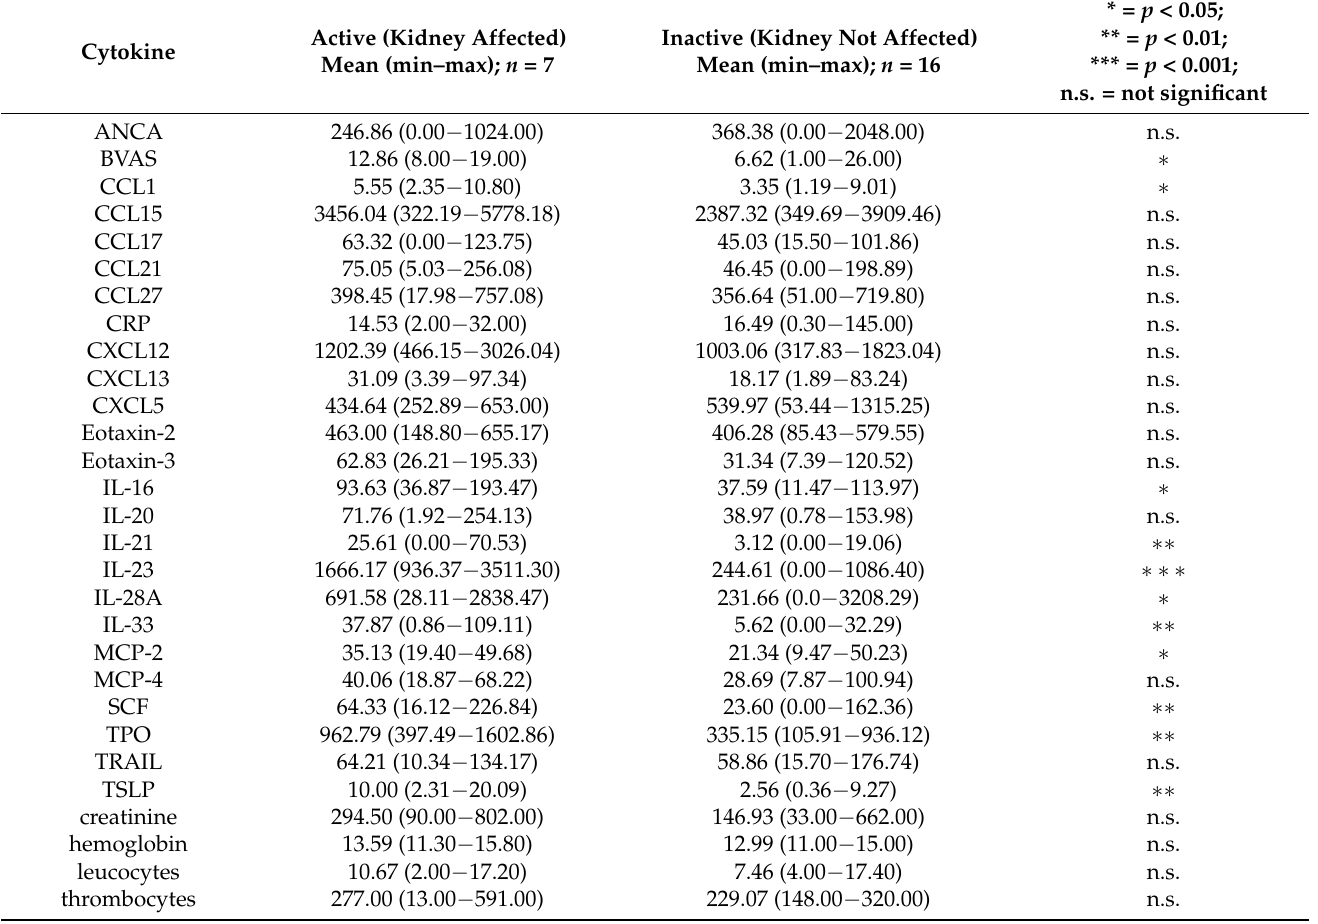
Table 4. Cytokines, laboratory parameter, PR3-ANCA titer, and BVAS at active AAV with and without kidney involvement.